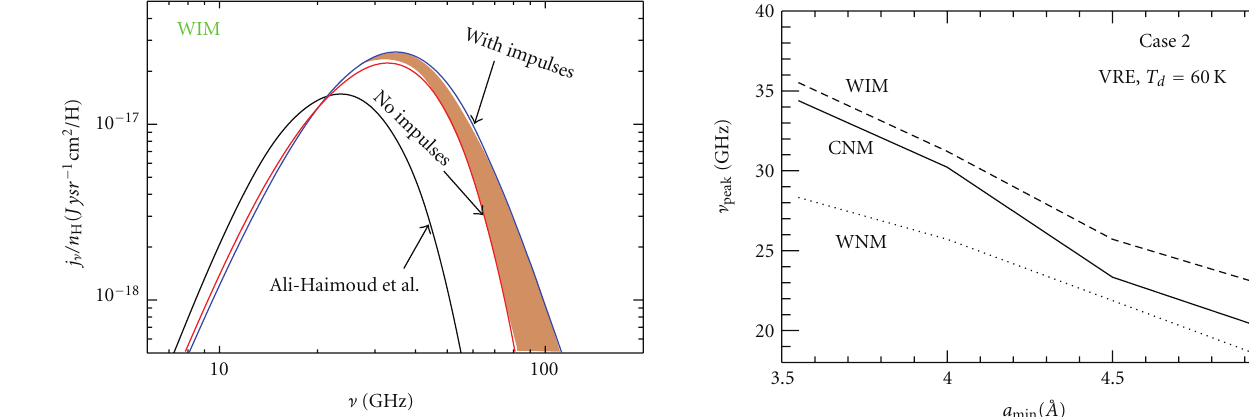
Figure 5: Decrease of the peak frequency ν peak of spinning dust spectrum with the lower cuto ff of grain size distribution a min for various environmental conditions. The figure is reproduced from Hoang et al.